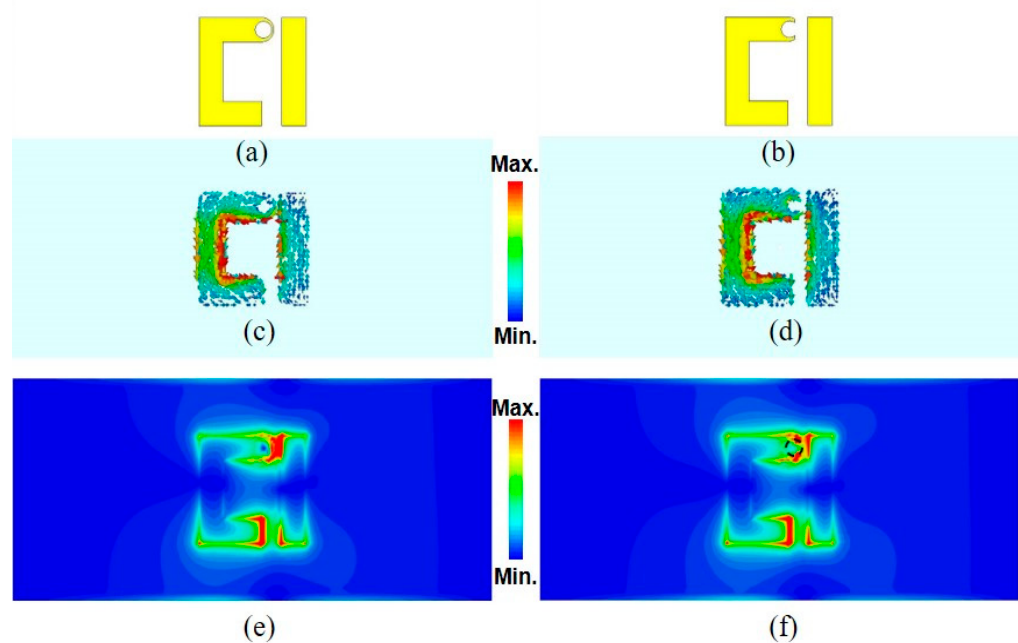
Figure 5. ( a ) Full-circle single asymmetric split resonator design; ( b ) semi-circle single asymmetric split resonator design used in this paper; ( c , d ) the surface current distribution for both designs in ( a , b ), respectively; and ( e , f ) the spatial electric- field distribution for both designs in ( a , b ) showing the reason behind choosing the semi-circle design and placing the glucose drops at the semi-circle spot. The dashed semicircle in ( f ) shows the spot where the glucose solution has been placed.